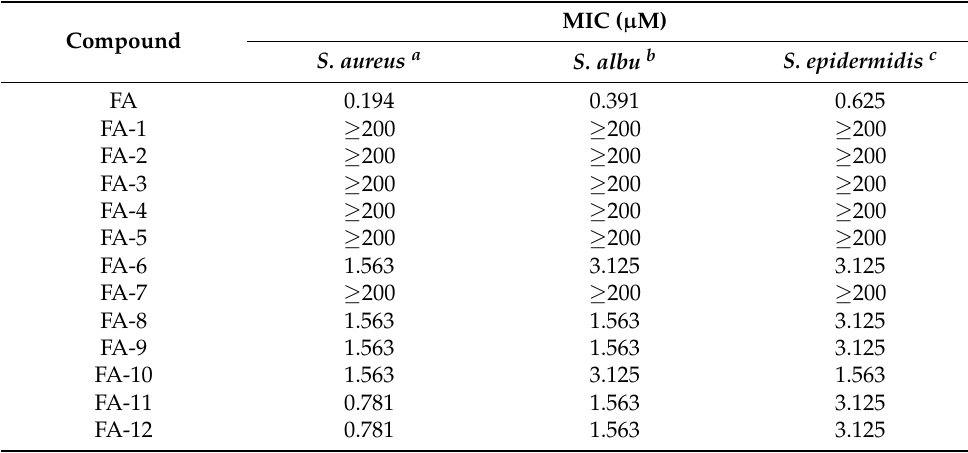
Table 2. Antibacterial activity of FA and its derivatives expressed in MIC ( µ